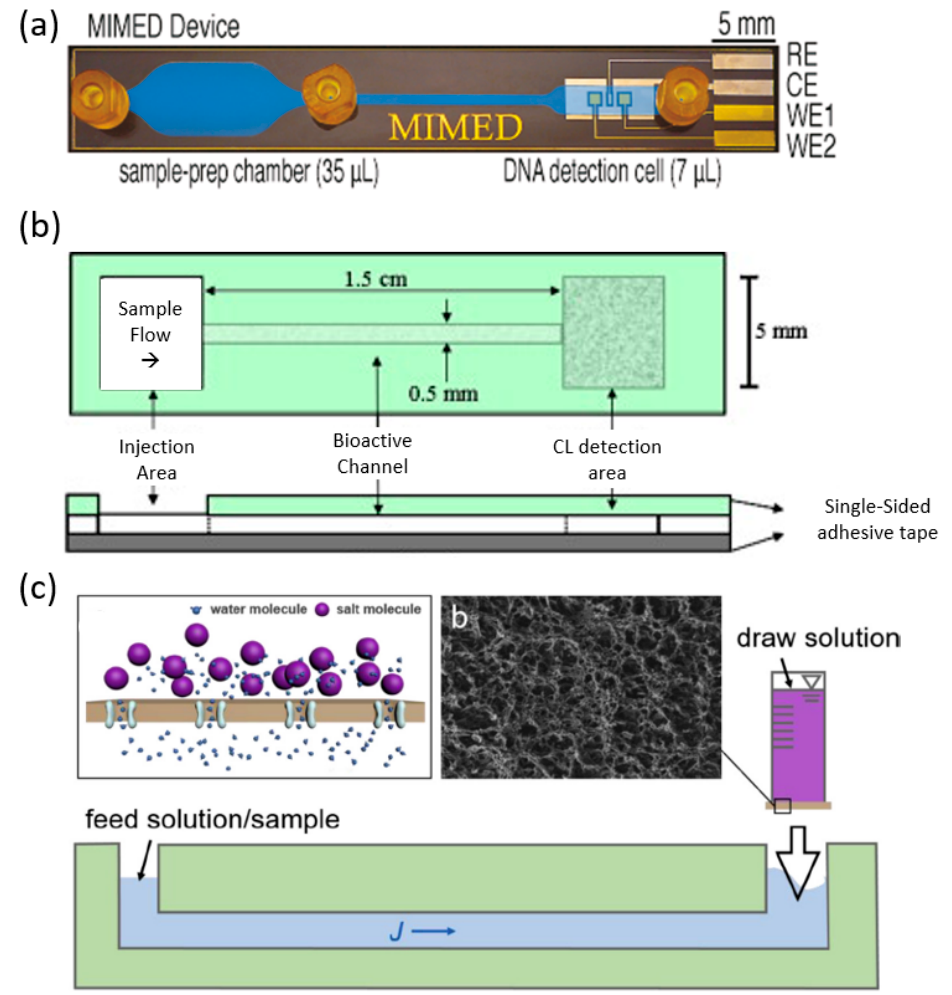
Figure 8. Microfluidic integrated biosensors. ( a ) Magnetic Integrated Microfluidic Electrochemical Detector device for detection of H1N1 [20]. ( b ) Schematic of a paper microfluidic biosensor for uric acid determination [59]. ( c ) Schematic of a microfluidic device driven by osmotic pressure [60].